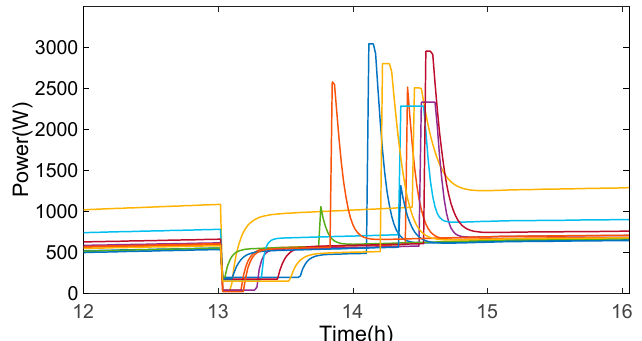
Figure 13. The power changes of 10 IACs of aggregated IAC load.